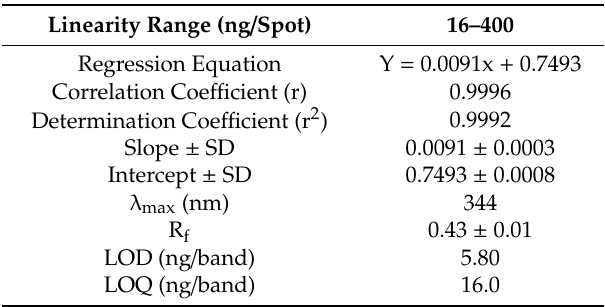
Table 1. Linear regression analysis data and quantitative parameters of DLX ( n = 6) . Limit of detection (LOD) and limit of quantification (LOQ).